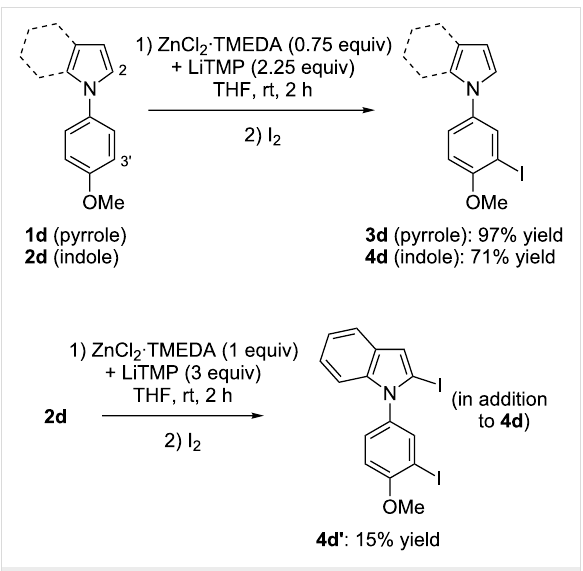
Scheme 4: Deproto-metallation of 1b and 2b followed by